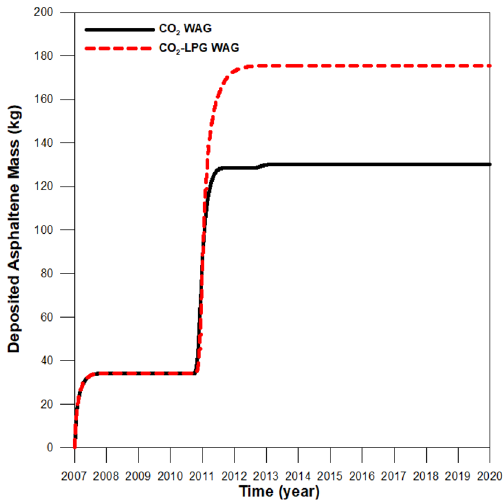
Figure 6. Asphaltene deposition at the middle of the reservoir during CO 2 and CO 2 -LPG WAG injection.